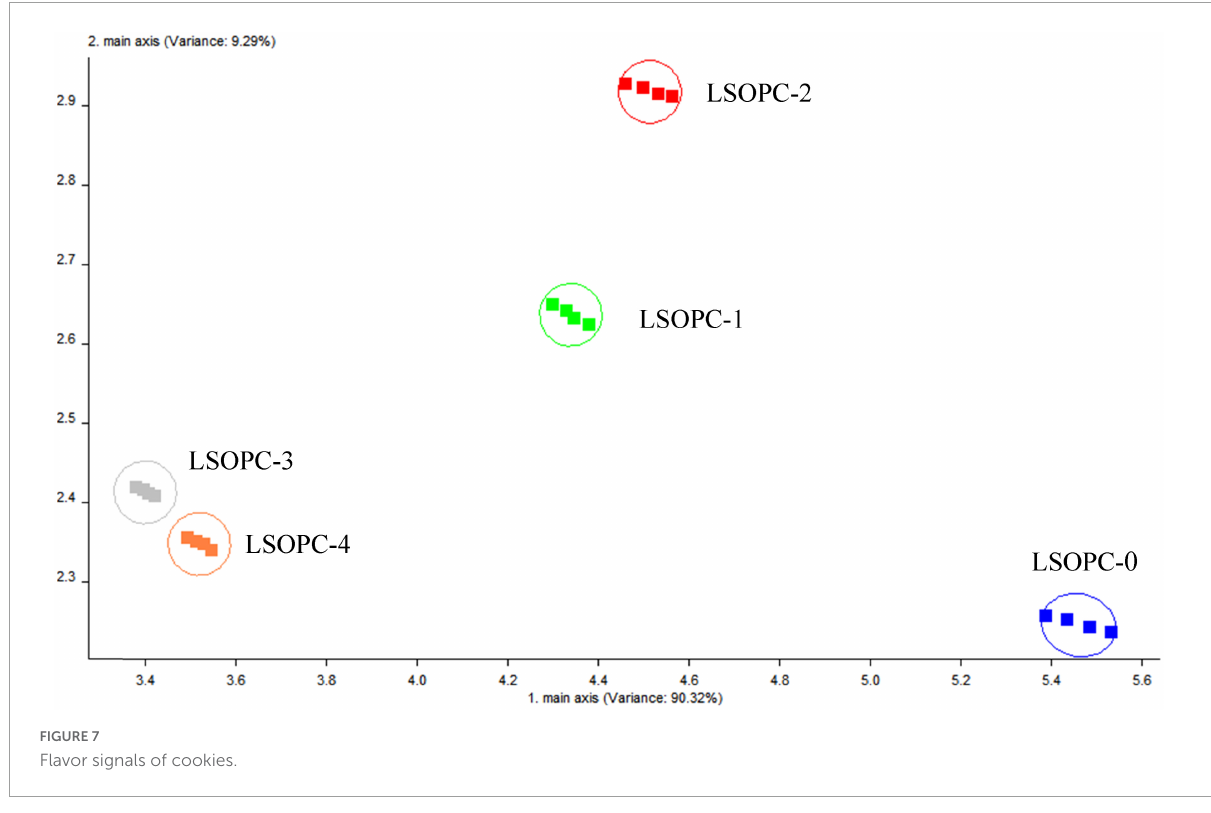
FIGURE7 Flavor signals of cookies.